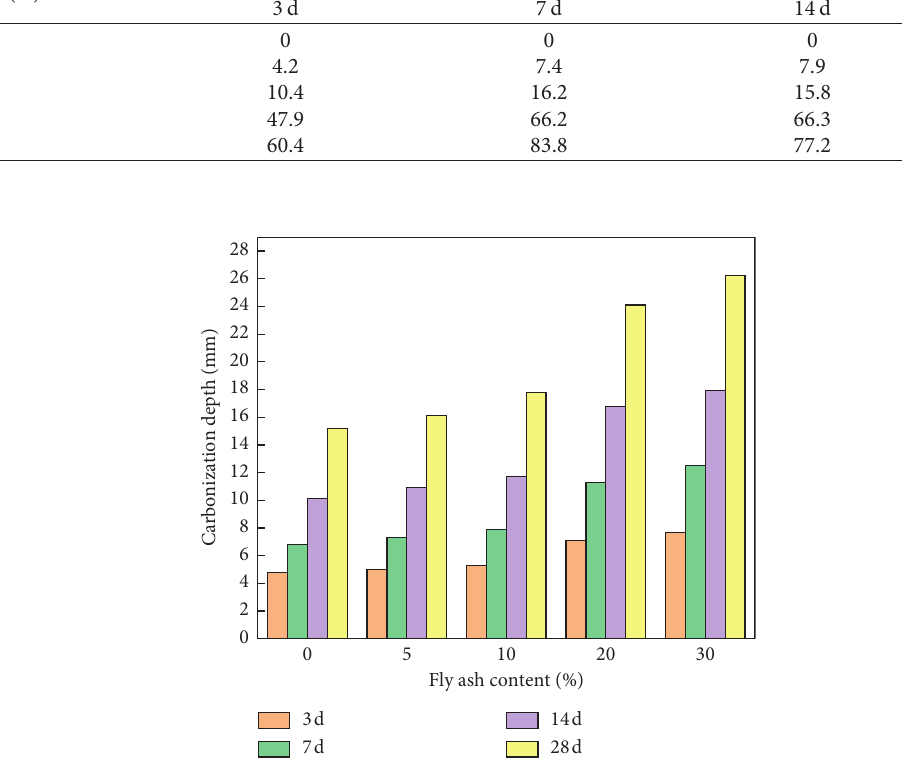
Table 3: Influence of fly ash content on carbonization depth of hybrid fiber concrete. Fly ash content (%)